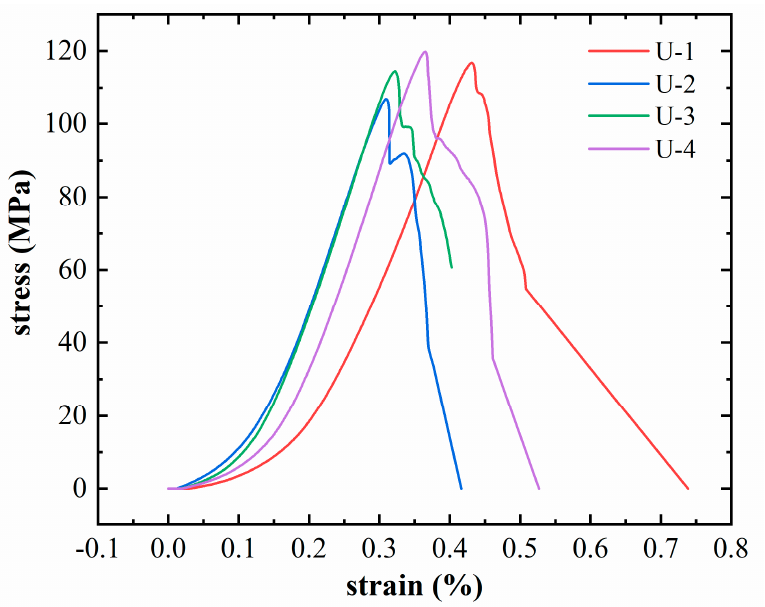
Figure 3. Stress-strain curve of uniaxial compression test. Table 2. Statistics of uniaxial compression test results.